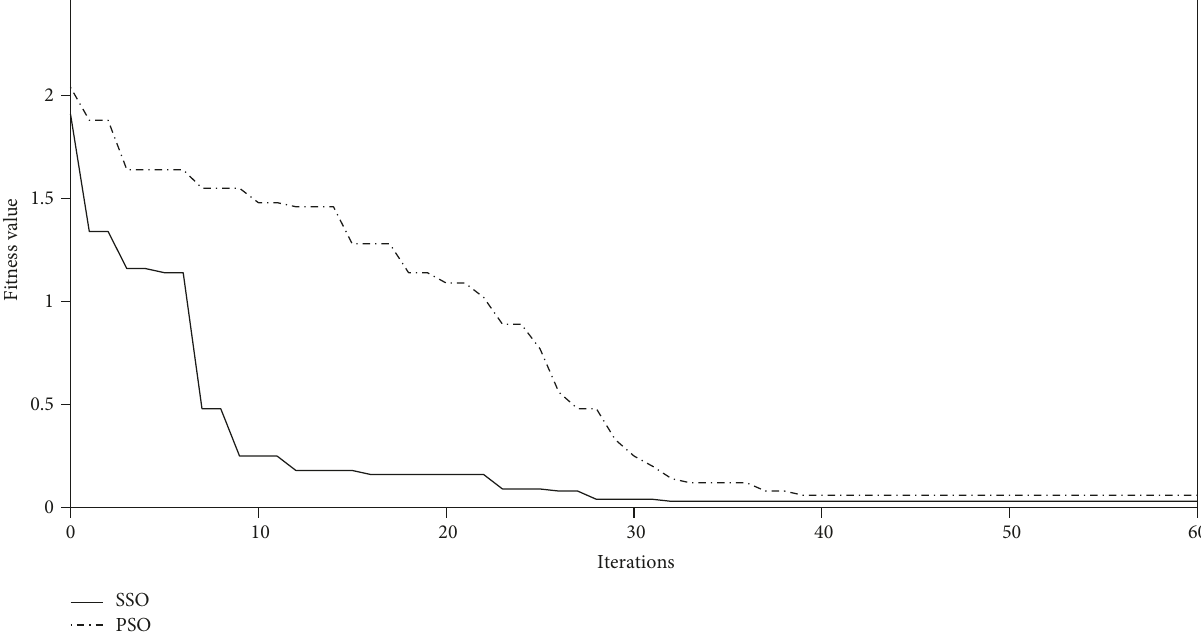
Figure 12: Comparison of the convergence of SSO and PSO